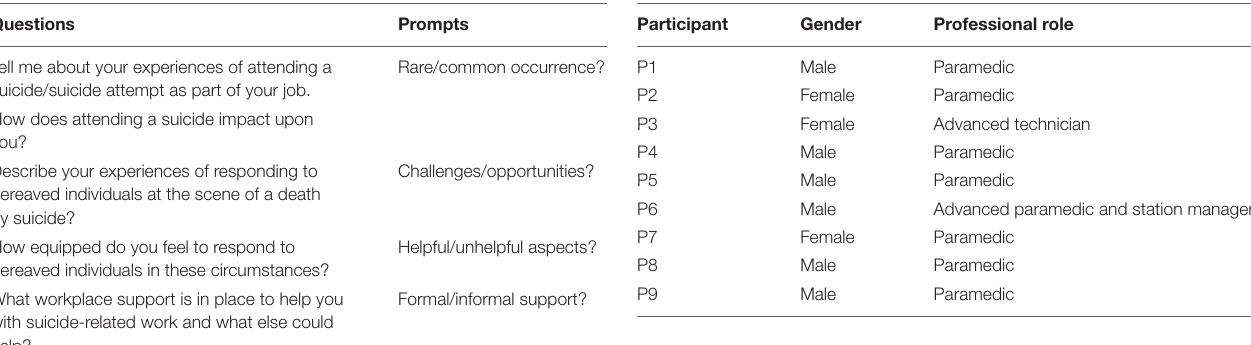
TABLE 1 | Interview topic guide. TABLE 2 | Final sample